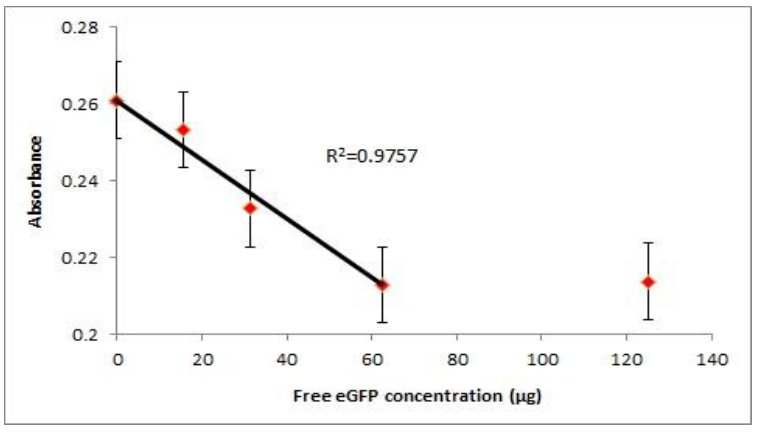
Figure 4. Competitive assay between the probe and the free eGFP against the antibody (scFv format). Linear relationship between the absorbance readout and the concentration of free eGFP ( n = 3) where each data point represents an average of three absorbance readouts (each error bar indicates the standard